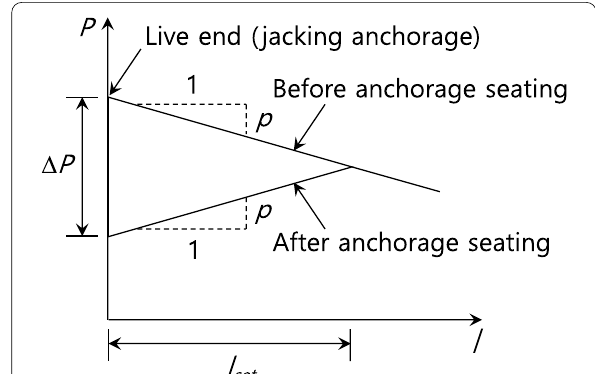
Fig. 3 Prestressing force (PF) distribution affected by anchorage seating